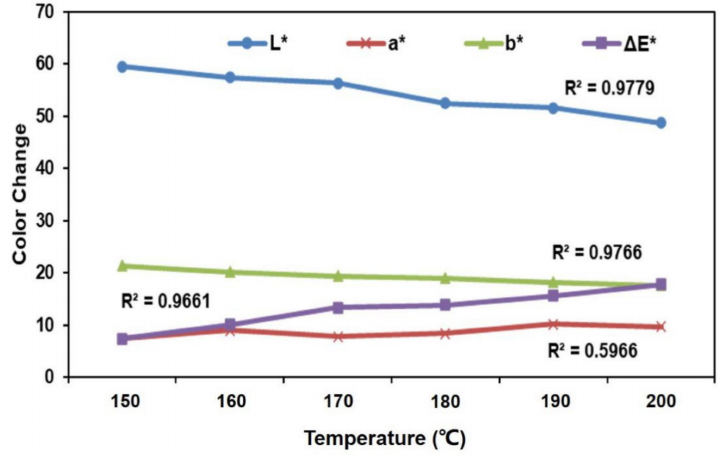
Figure 8. Color parameters of BFBC manufactured at different